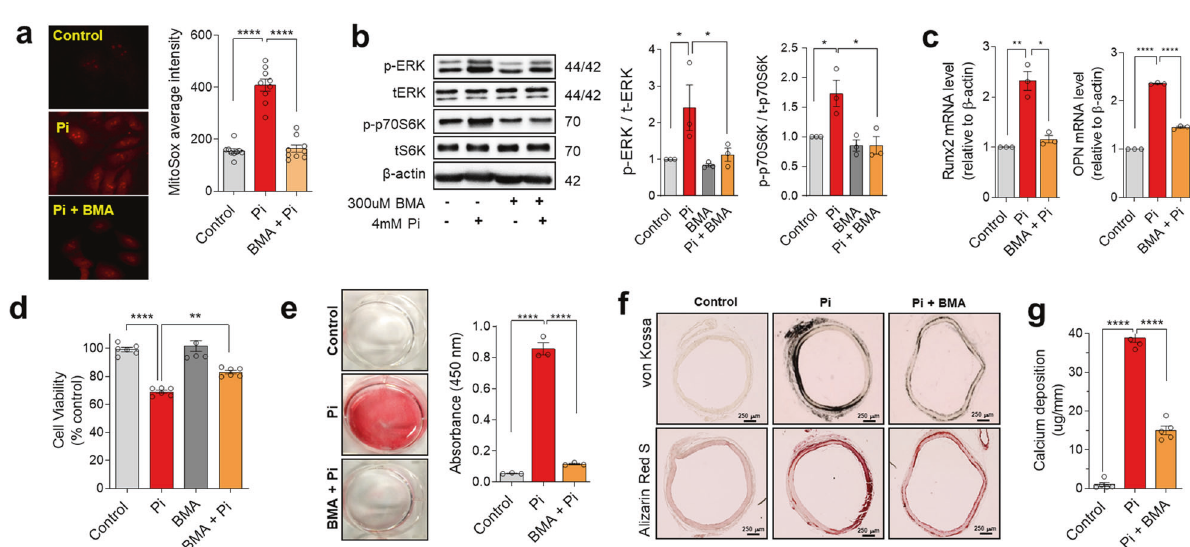
Fig. 3 Pharmacological blockade of mitochondrial phosphate (Pi) transport prevents vascular calci fi cation caused by high Pi. a Mitochondrial superoxide production in control and butyl malonate (BMA)-treated primary vascular smooth muscle cells (pVSMCs) was determined using mitoSOX (# experiments; n = 9). b Immunoblotting of ERK1/2 and p70S6K was performed (# experiments; n = 3). c The transcript levels of osteogenic genes were estimated using quantitative PCR (# experiments; n = 3). d Cell viability was evaluated using an MTT assay (# experiments; n = 5). e Calci fi cation was quantitated using Alizarin Red S staining (# experiments; n = 3). f Calci fi cation of rat aortic rings after high-Pi incubation ex vivo with and without BMA treatment for 7 days as visualized by Alizarin Red S or von Kossa staining. g